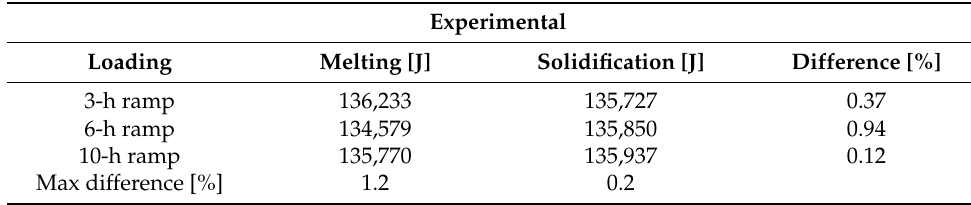
Table 6. Energy balance, based on the experimental heat flux.